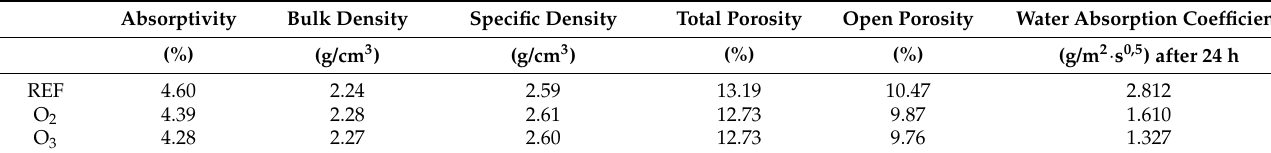
Table 4. Physical properties of the tested concretes.